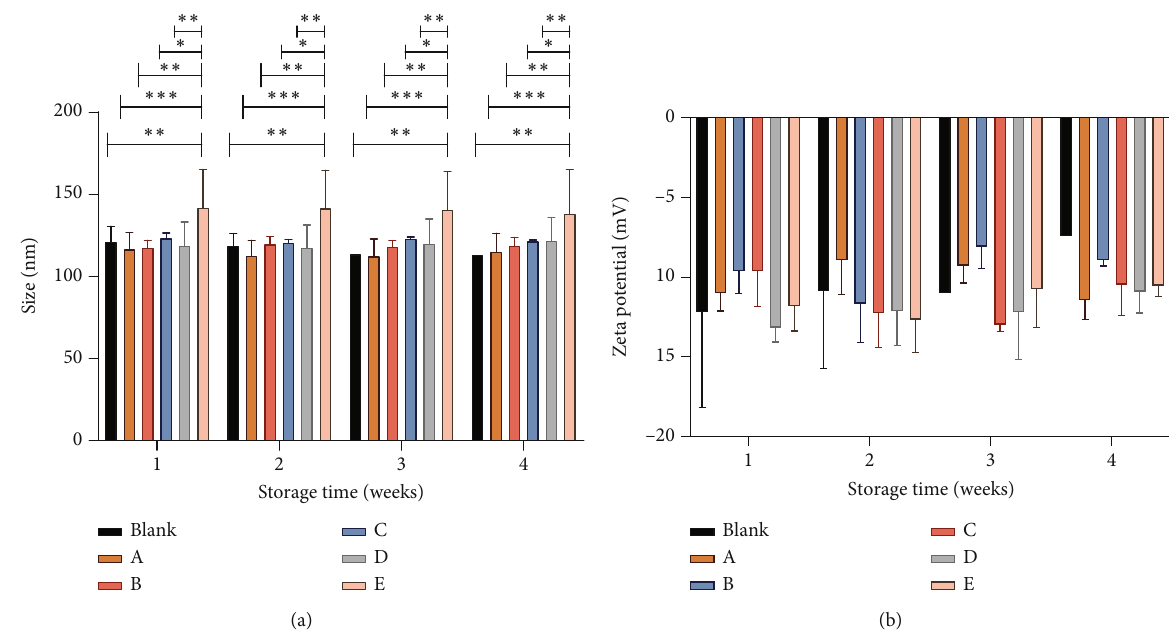
Figure 2: Liposomes ’ characterization: (a) size and (b) zeta potential. Lines are shown only when there is a signi fi cant di ff erence between two samples, in which asterisks denote the level of signi fi cance. ∗ p < 0 : 05 , ∗∗ p < : 001 , and ∗∗∗ p < : 0001